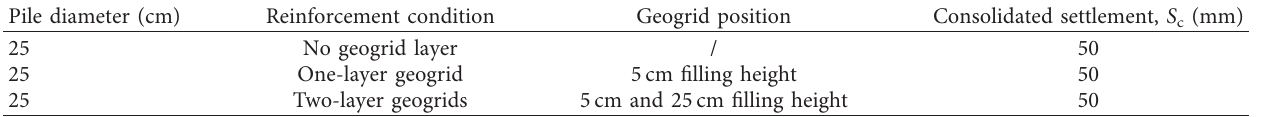
Table 1: Experiment series.